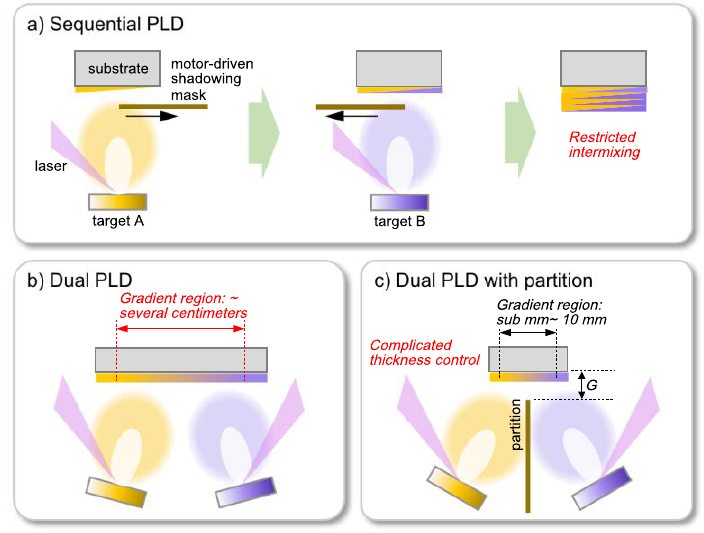
Figure 1. Schematics of PLD setups for fabricating compositionally-graded films. ( a ) Sequential single-beam PLD. ( b ) Simultaneous dual-beam PLD without partition. ( c ) Partitioned, simultaneous dual-beam PLD.